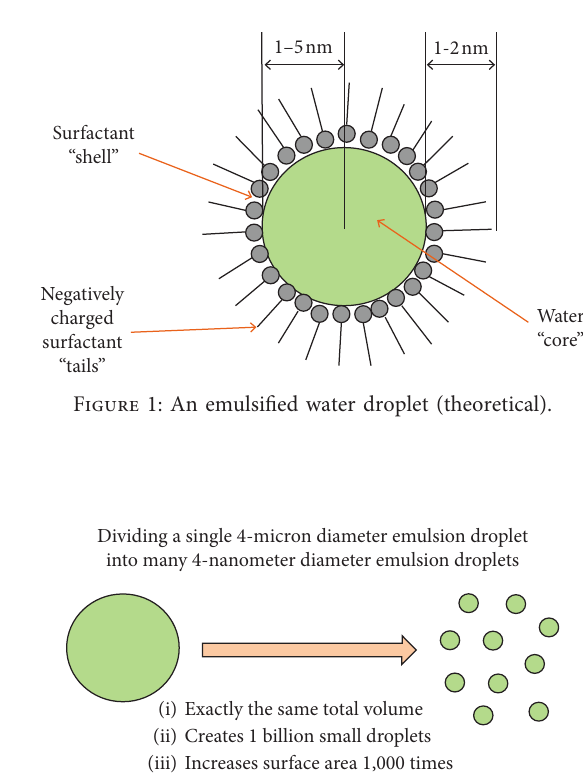
Figure 2: Reducing emulsified water droplet